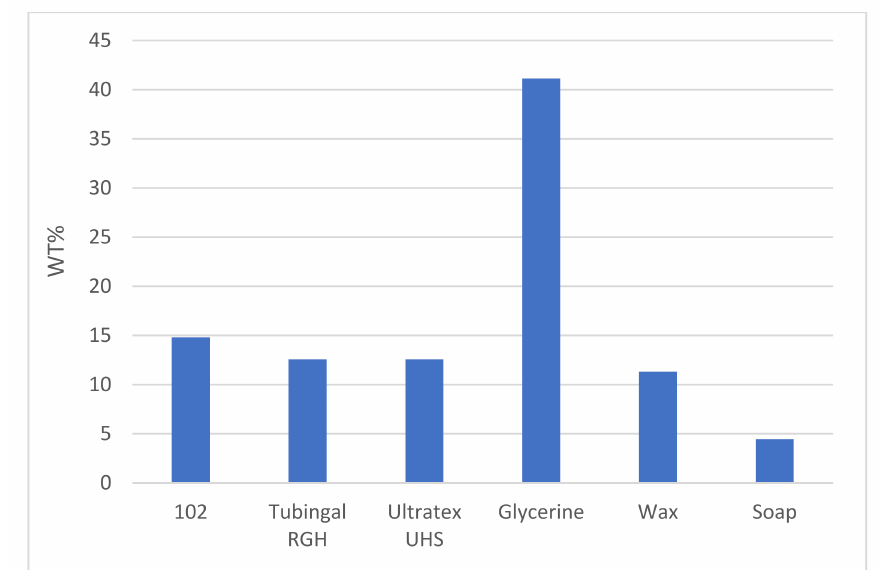
Figure 5. Increase in wt% of paper yarn due to the application of finishing materials.